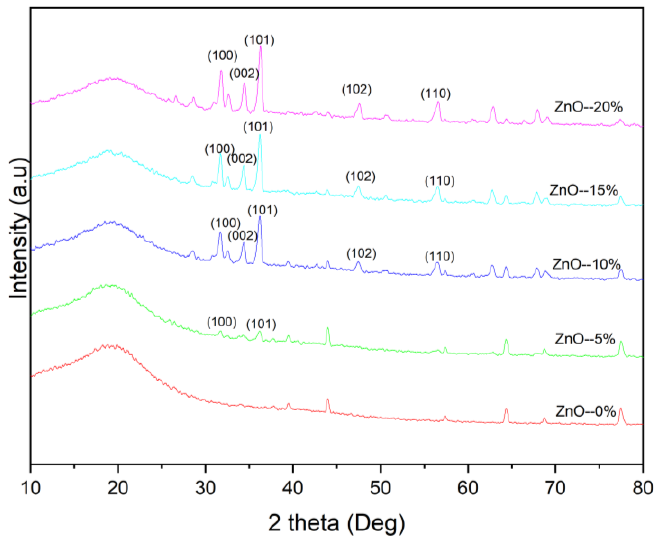
Figure 8. X-ray diffraction patterns of foamed polymer composites at different ZnO fillers.